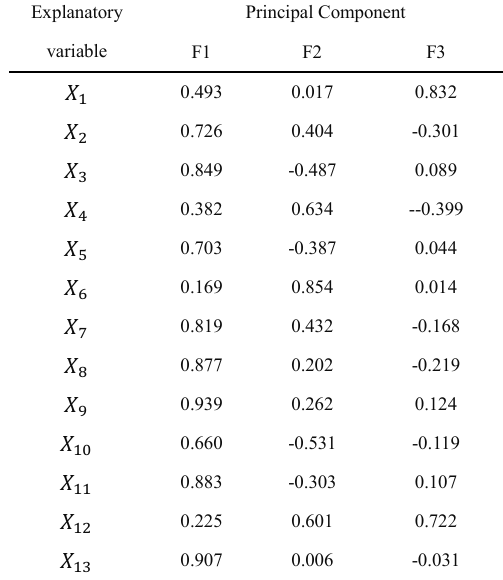
Table 6. Load of principal component of user access volume After calculating the load matrix according to the